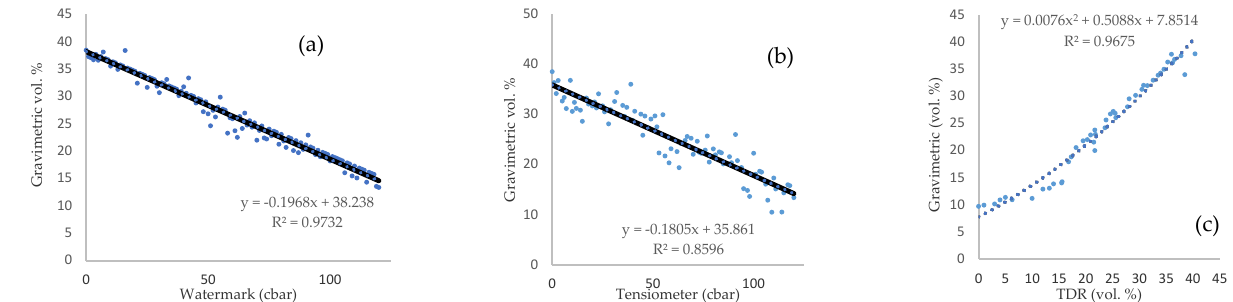
Figure 7. Relationship between sensor readings and laboratory calibrations for Watermark ( a ), Tensiometer ( b ) and TDR ( c ).